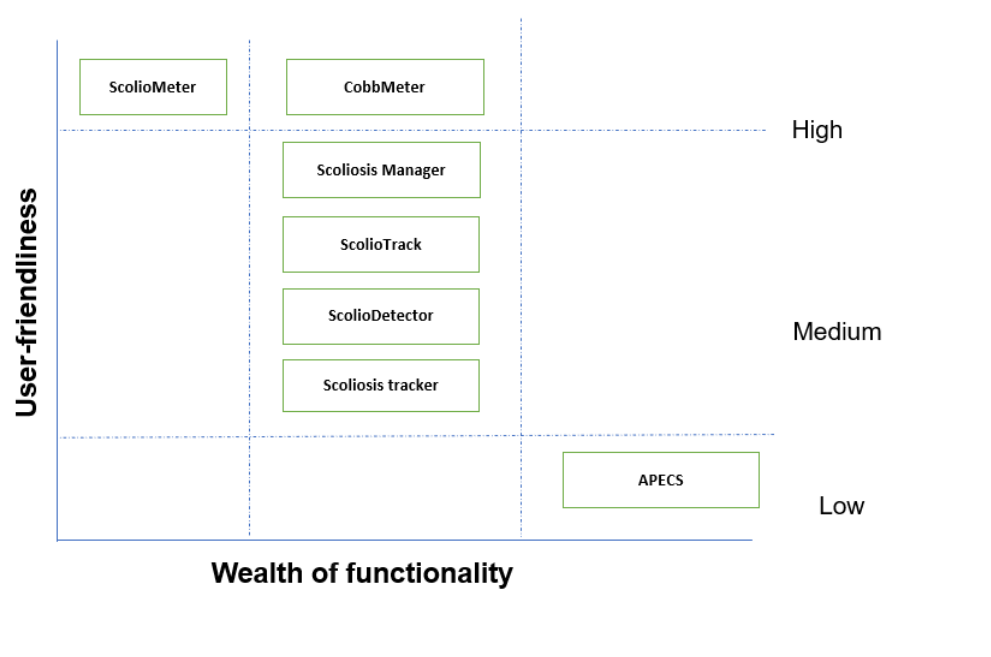
Figure 9. Tool assessment with respect to “Wealth of functionality” and “User-friendliness”